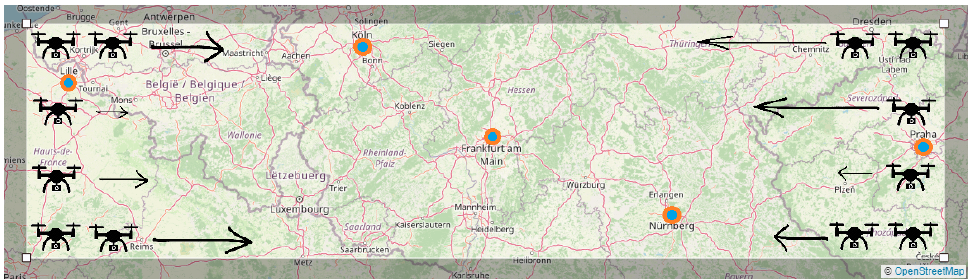
Figure 3. The area of movements and the position of the fog